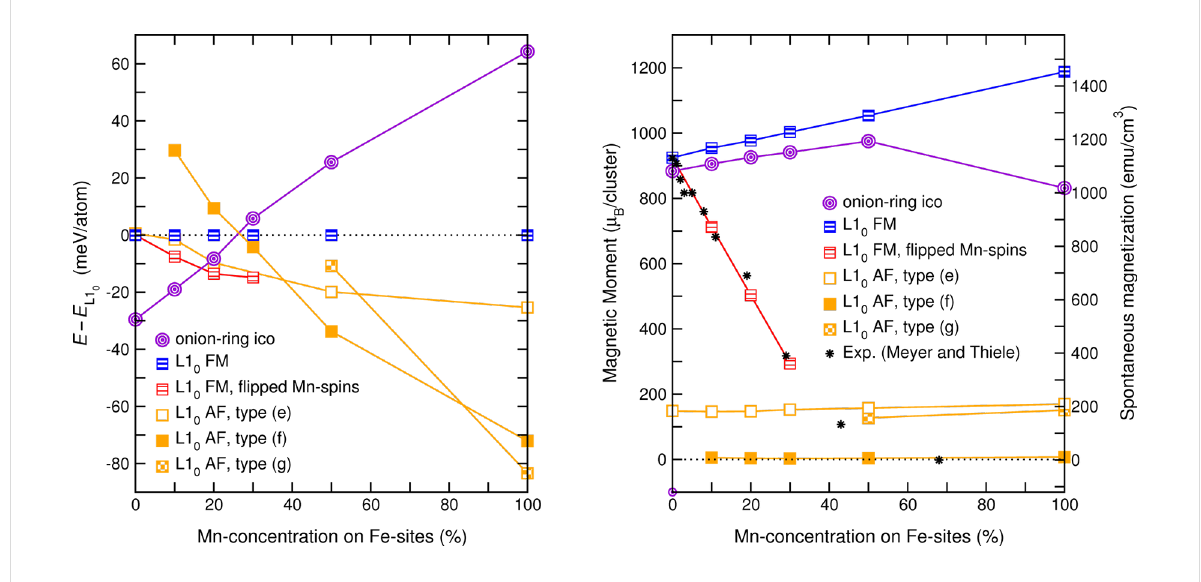
Figure 2: Energetic order (left panel) and magnetization (right panel, left scale) of ternary 561 atom Fe–Mn–Pt clusters with different morphologies and magnetic structures as a function of composition (Fe sites randomly replaced by Mn). Blue squares denote the ferromagnetic (FM) and perfectly ordered L1 0 isomer (d), which again is chosen as reference for each composition, violet nested circles the alternating icosahedron (b). Orange square refer to antiferromagnetic (AF) clusters: Filled symbols to a staggered antiferromagnetic configuration (f), open symbols to a layerwise alternating arrangement of ferromagnetic 3d layers parallel to the c axis (e), half-filled symbols to an antiferromagnetic arrangement layered perpendicular to c (g). Red symbols denote a ferromagnetic configuration (d), where Fe and Mn moments point in opposite directions. The black stars refer to the experi- mental saturation magnetization (right scale) obtained by Meyer and Thiele